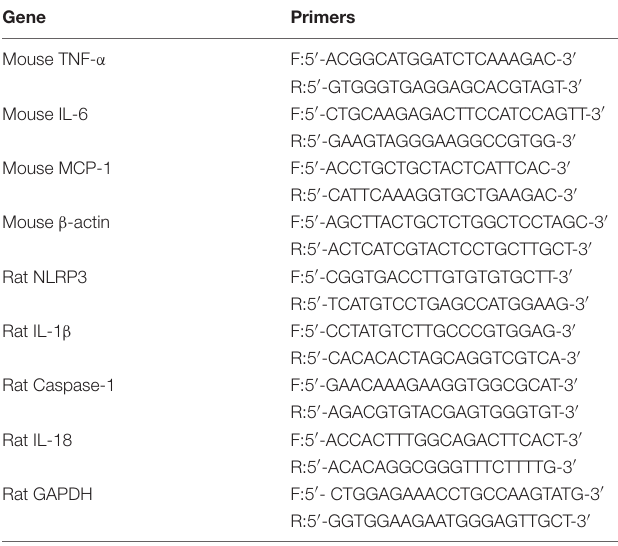
TABLE 1 | Primer oligonucleotide